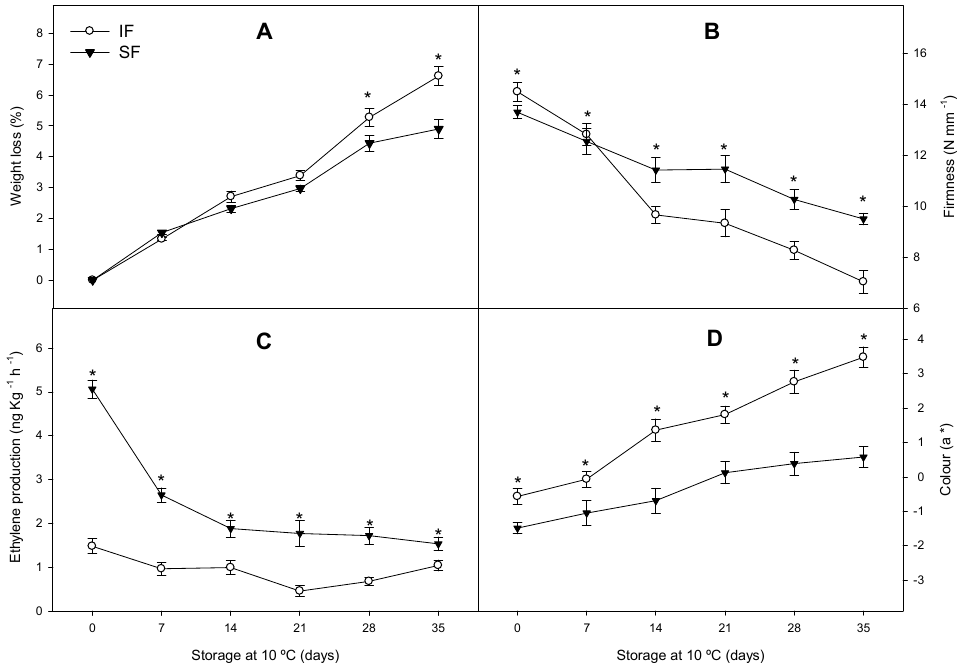
Figure 2. Effect of standard fertigation (SF) and intensive fertigation (IF) on weight loss ( A ), firmness ( B ), ethylene production ( C ) and colour ( D ) in lemon fruits stored for 35 days at 10 °C. Asterisks (*) show significant differences between lemon fruits cultivated with IF and those with SF at p < 0.05.